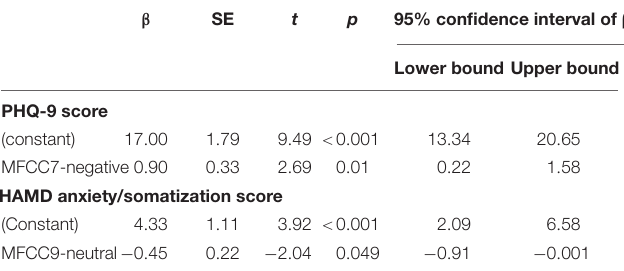
TABLE 4 | Linear regression analysis between PHQ-9 score and MFCC7-negative.